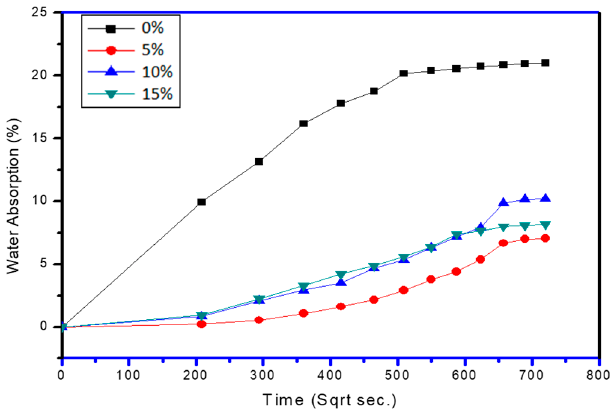
Figure 8. Water absorption properties of graphite-loaded composites.